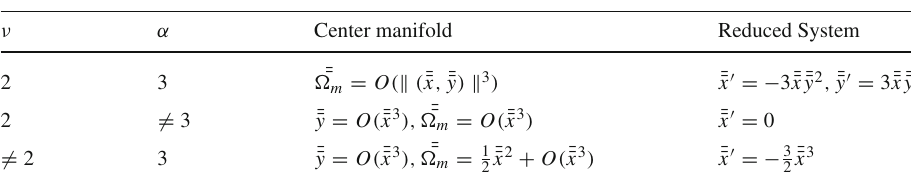
Table 8 The critical point C 3 , a Case ν Stability(RS) Stability(DS) summary < 1 NA Saddle Center Center-saddle > 1 NA Saddle